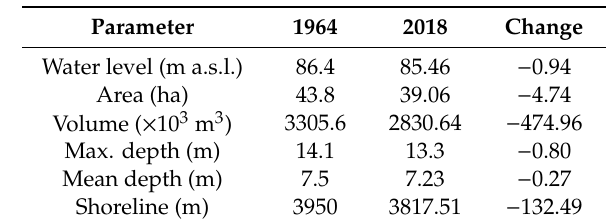
the lakes. Table 6. Morphometric data of Lake Borówno on the basis of measurements in 1964 [71], and own measurements in 2018. Table 6. Morphometric data of Lake Bor ó wno on the basis of measurements in 1964 [71], and own measurements in 2018.